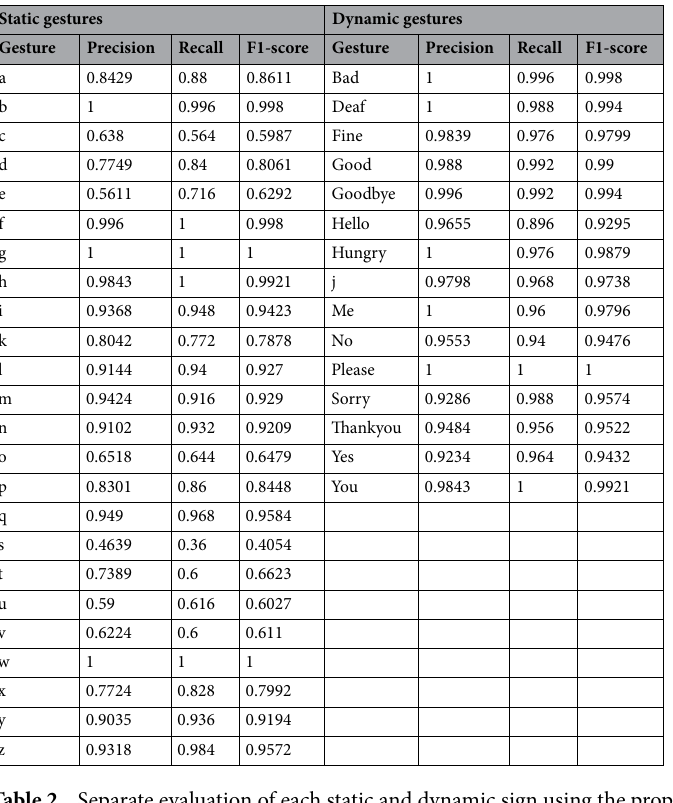
Table 2. Separate evaluation of each static and dynamic sign using the proposed method.